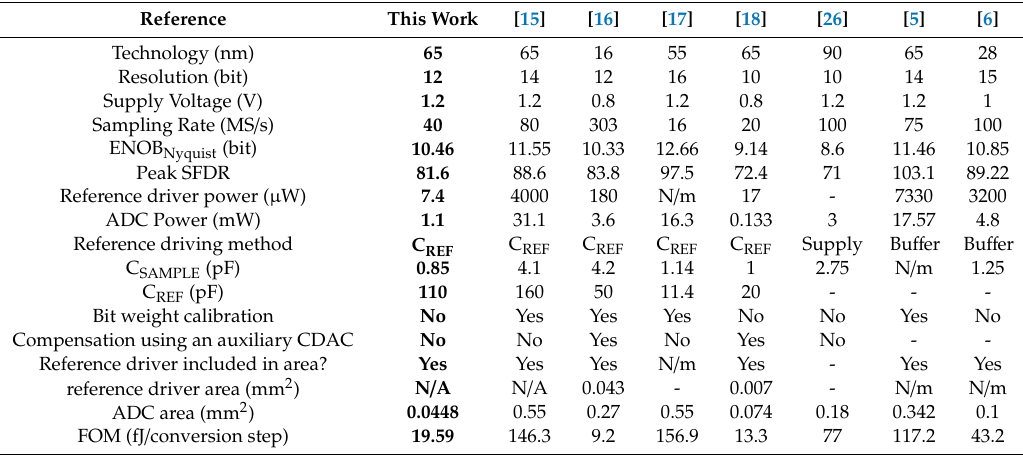
Table 2. Performance summary and